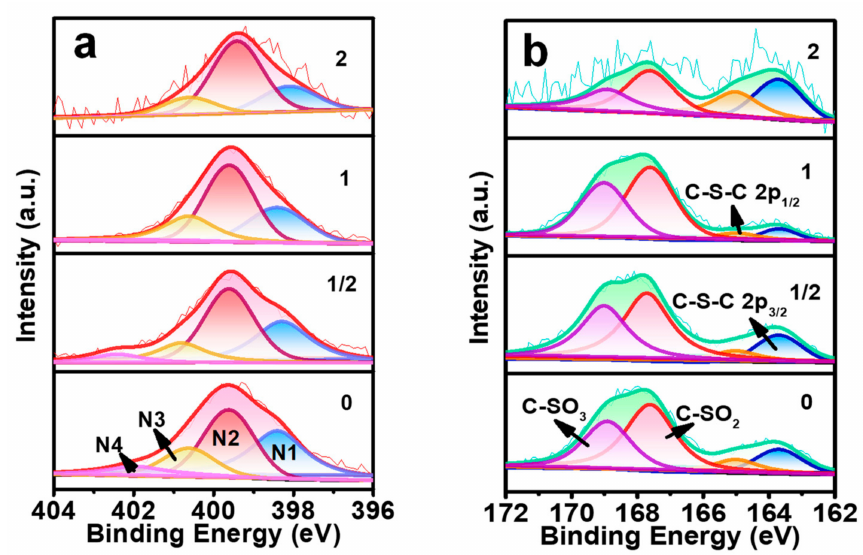
Figure 3. ( a ) N1s XPS spectra for different K 2 CO 3 loading content-induced NSC materials (N1 pyridinic N, N2 pyrrolic N, N3 quaternary N, N4 oxidic N), ( b ) S 2p spectra for different K 2 CO 3 loading content-initiated NSC materials. The activation conditions were set to be 700 ◦ C, KSCN: biomass mass ratio = 1:1, various mass ratios between K 2 CO 3 and